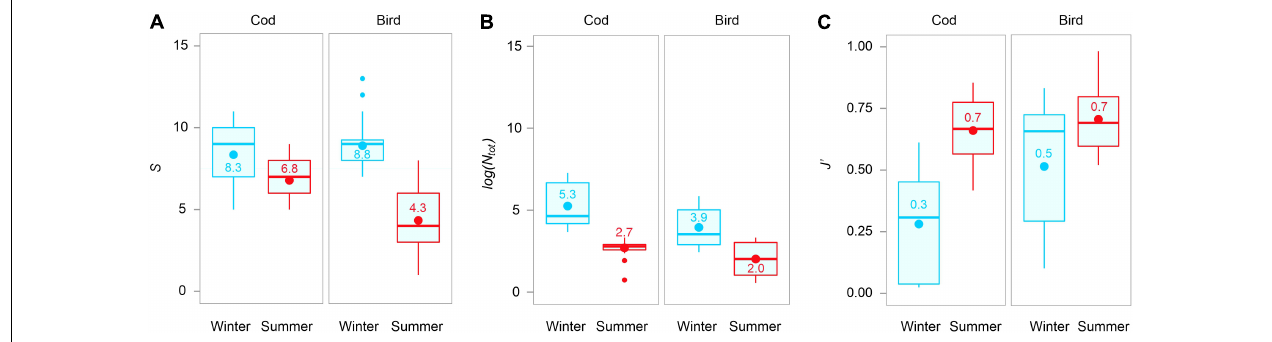
FIGURE 7 | (A) Species richness ( S ), (B) log-transformed total abundance log(N tot ), and (C) Pielou’s evenness ( J (cid:48) ) for different bait types in each of two seasons. Horizontal line in the middle of the inter-quartile range represents the median, bigger dots = average values, smaller dots = potential outliers.